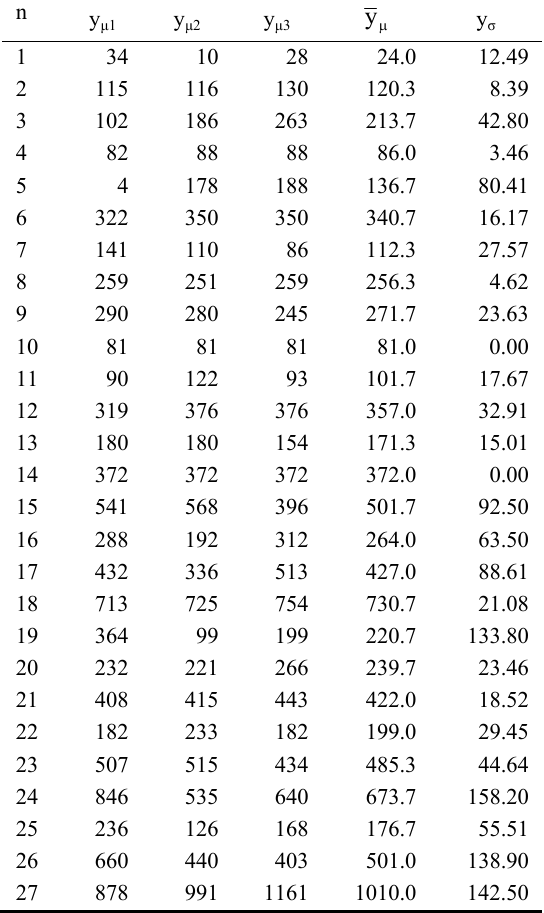
Table 5. Experimental results for the printing ink process